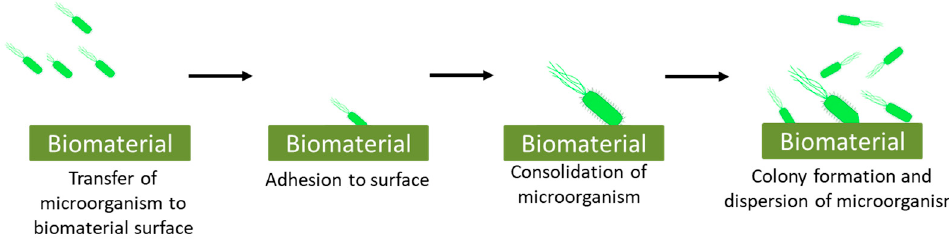
Figure 5. Representation of steps involved in attachment of microorganism to the surface which results in biomaterial related infections.